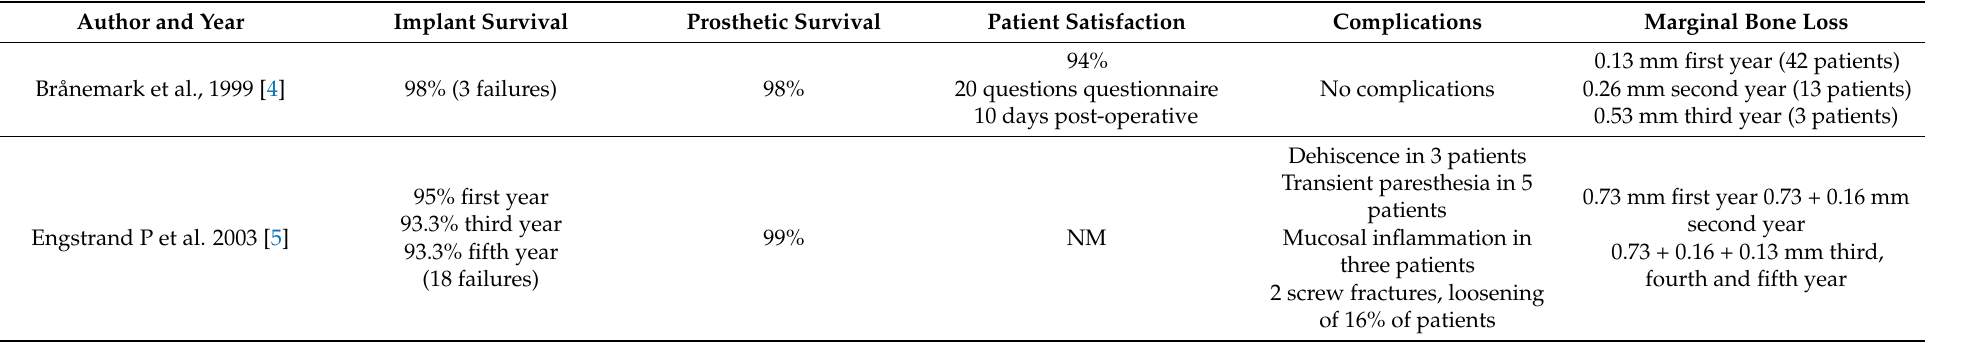
Table 2. Information about selected studies evaluating ISFCDPs on 3 dental implants, including implant and prosthetic survival rate, patient-reported outcomes, complications and marginal bone